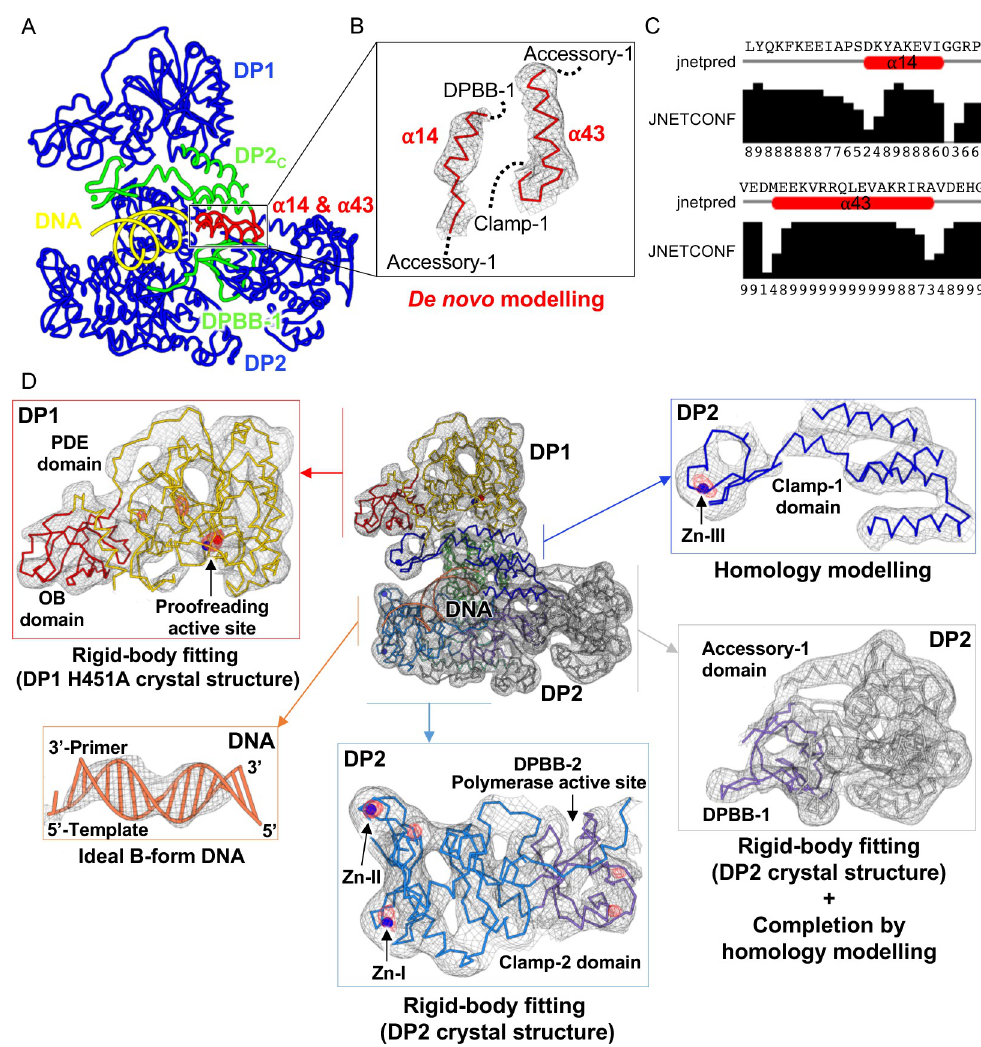
Fig 2. Cryo-EM reconstruction of the DNA-bound PolD binary complex. (A) Backbone trace of the cryo-EM model of PolD. The blue region was built by fitting the DP1 H451A (PDB ID: 6HMF, this study) and DP2 (PDB ID: 5IJL [15]) crystal structures in the cryo-EM map. The C-terminal region of DP2 (1090–1195) (green) was built guided by the homology with the CTD of the catalytic subunit of human Pol ε (PDB ID: 5VBN [24]) and adjusted manually in the cryo- EM density. Part of the DPBB-1 domain and the DPBB-connecting loop (green) were built by homology modeling guided against the structure of yeast RNAP-II (PDB ID: 2E2I [25]). A 15-/16-mer B-form DNA was generated with Coot [26] (yellow) and rigid-body fitted into the cryo-EM density. Finally, two α helices (red) were built de novo in the cryo-EM density: α 14 (324–338) and α 43 (1074–1089)). (B) Enlarged view showing the α 14 and α 43 α helices that were built de novo. The cryo-EM map surrounding these helices is shown as a gray mesh contoured at 6 σ . (C) Secondary structure predictions of Jpred [27] for the de novo–built α 14 and α 43 α helices. The confidence factor is indicated: 0, not confident, and 9, very confident. (D) Detailed views of the DNA-bound PolD cryo-EM experimental map. Density surrounding PolD and DNA is shown in gray mesh contoured at 6 σ . Residual peaks of density are shown in red mesh contoured at 12 σ . cryo-EM, cryo–electron microscopy; CTD, C-terminal domain; DPBB, double-psi β -barrel; OB, oligonucleotide binding; PDB, Protein Data Bank; PDE, phosphodiesterase domain; RNAP, RNA polymerase. required for rearranging the DP2 catalytic core into an active conformation. Indeed, in the DP2 (1–1061) crystal structure, deletion of the CTD of DP2 causes a profound reorganization of the active site (Fig 3A): (1) the DPBB-1 domain is partly disordered and moves with respect to DPBB-2 from the canonical relative orientation of the two-DPBB catalytic center that is